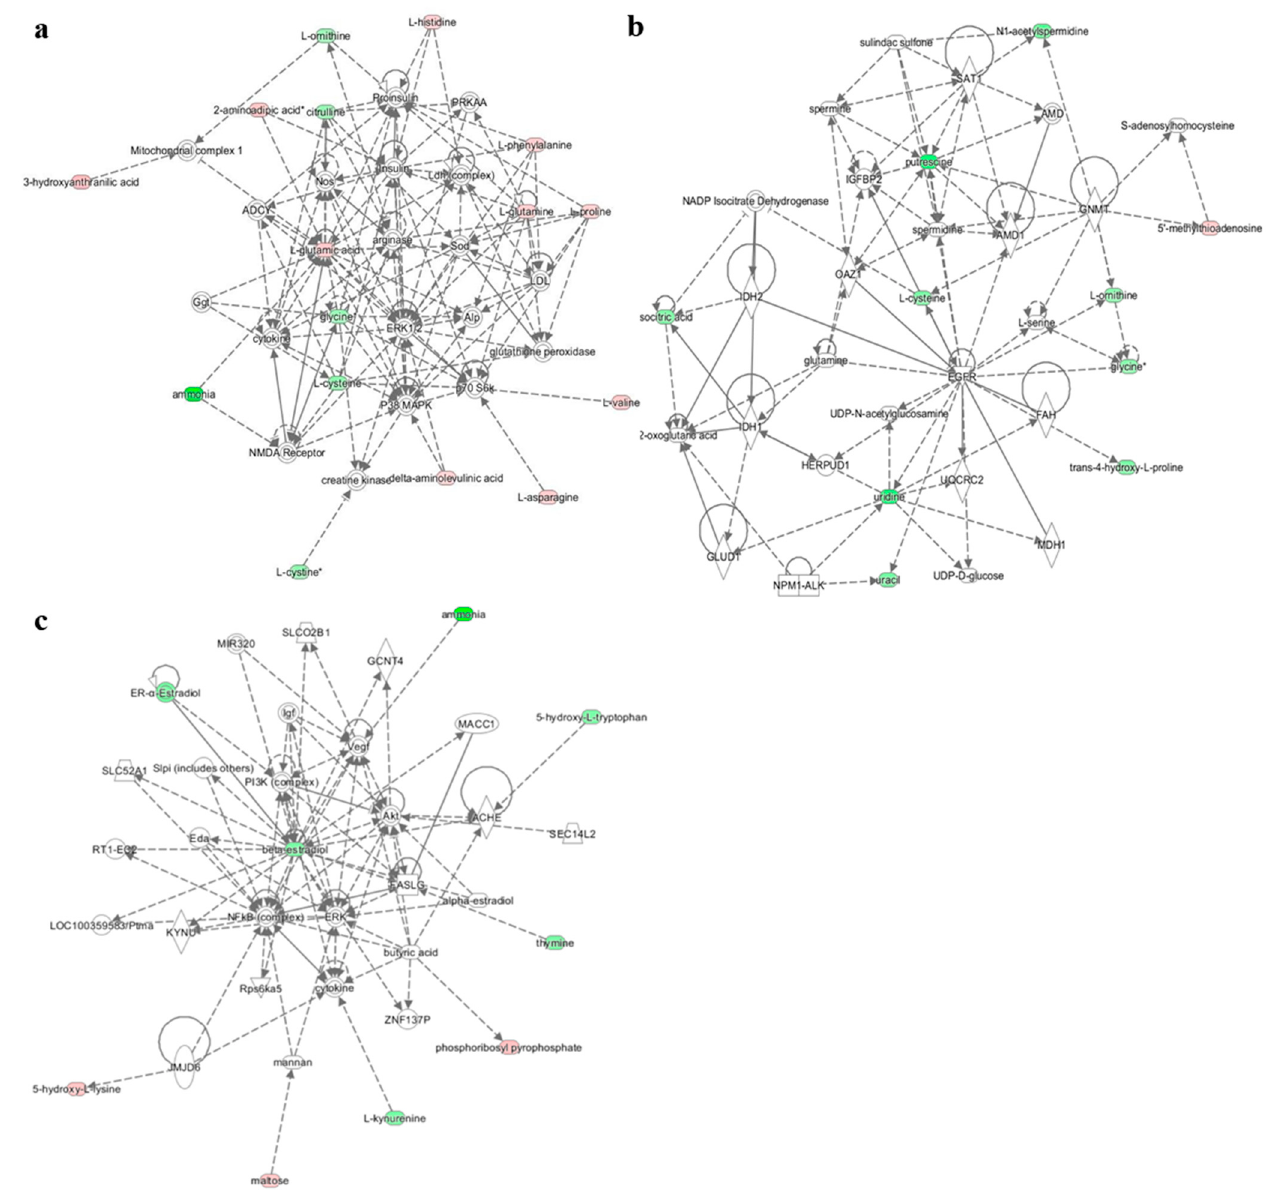
Figure 3. Significant biological networks associated with acute intervention with golden berry fruits. ( a ) Network associated with developmental disorders, hereditary disorders, and metabolic diseases. ( b ) Network associated with small-molecule biochemistry, molecular transport, and amino acid metabolism. ( c ) Network associated with cell morphology, cellular assembly and organization, and cellular development. Metabolites are represented as nodes. The biological relationship between two nodes is represented as a line. Note that the coloured symbols represent metabolites that occur not only in our data but also in Ingenuity® pathways correlations, while the transparent entries are molecules from the Ingenuity Knowledge Database. Metabolites highlighted in red have increased levels, whereas metabolites highlighted in green have decreased levels. Solid lines between molecules indicate a direct physical relationship between the molecules, and dotted lines indicate indirect functional relationships.